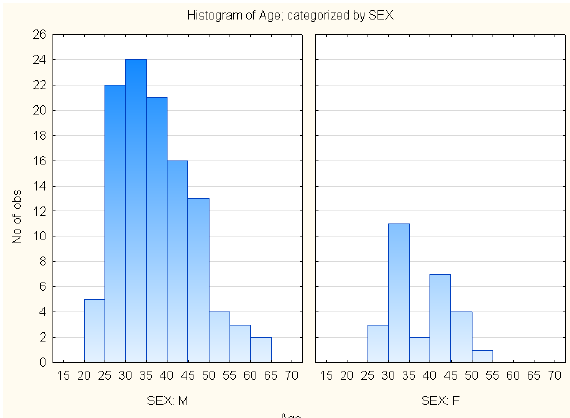
Figure 1. Pre and post-race plasma sodium [Na + ] con- centrations in the female and the male groups ( n = 113).